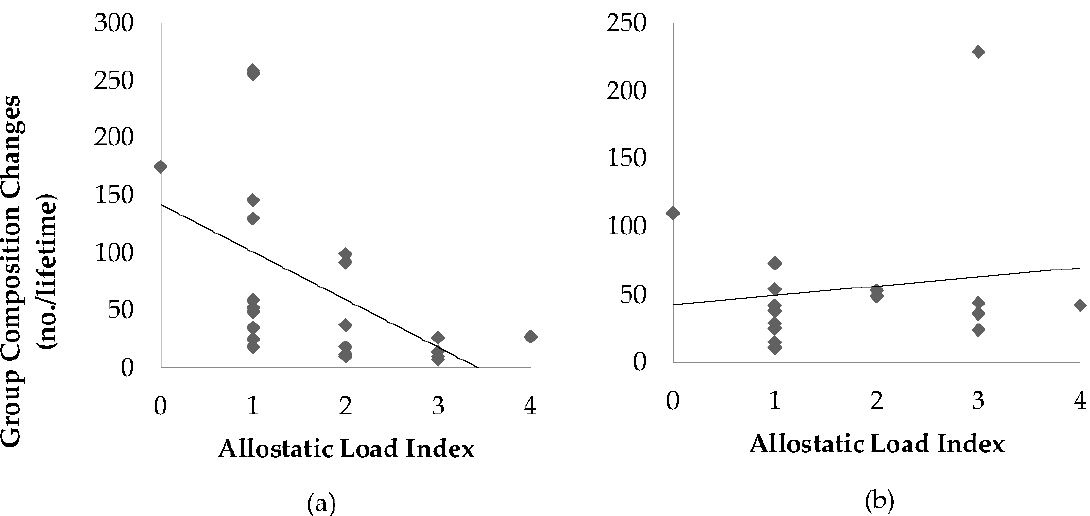
Figure 2. Scatter plot illustrating the association between allostatic load index and the total number of group composition changes experienced by ( a ) female ( n = 22) and ( b ) male ( n = 16) ring ‐ tailed lemurs ( Lemur catta ).